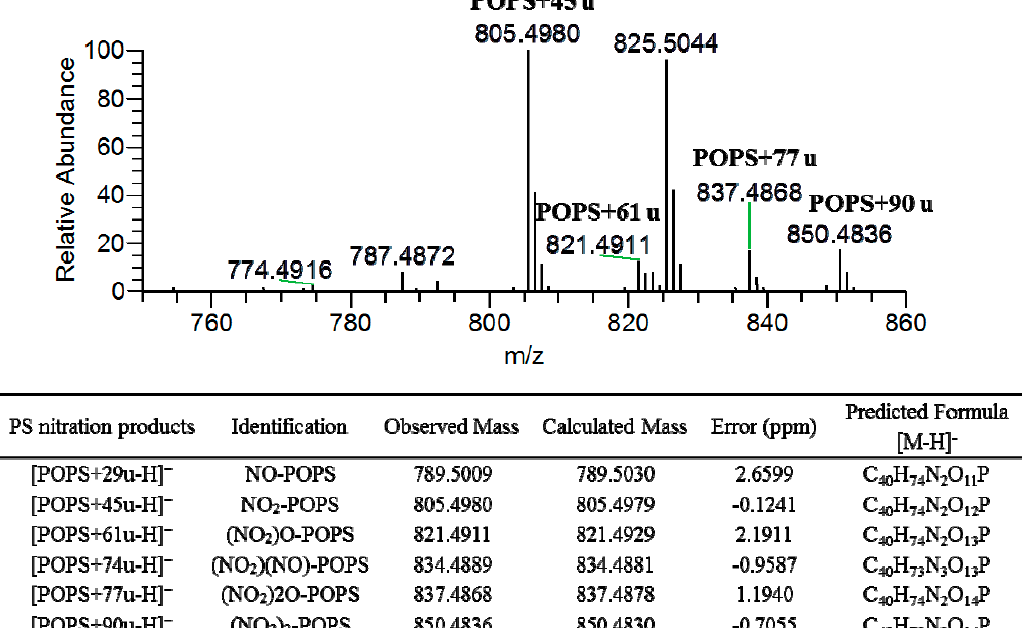
Figure 1. ESI-MS spectrum of POPS after nitration reaction acquired in the negative-ion mode in Q-Exactive Orbitrap. Assignments of nitrated and nitroxidized derivatives formed after reaction between NO 2 BF 4 and POPS observed in the ESI-MS spectrum as [M − H] − ions were confirmed by mass accuracy. The calculated and observed mass, error, and formula of the nitrated and nitroxidized derivatives formed after reaction between NO 2 BF 4 and POPS observed in the ESI-MS spectrum are also shown. Error (ppm) = (Observed m/z − Calculated m/z )/Calculated m/z ) × 1 × 10 6 . Table 1. Neutral losses and product ions observed in the ESI-MS/MS spectra acquired in the Q-Exactive Orbitrap mass spectrometer (HCD) of the nitrated and nitroxidized derivatives formed after reaction between NO 2 BF 4 and POPS, with the proposed identification, calculated and observed mass, error, and formula. Error (ppm) = (Observed m/z − Calculated m/z )/Calculated m/z ) × 1 × 10 6 . Proposed Precursor Ion Neutral Losses